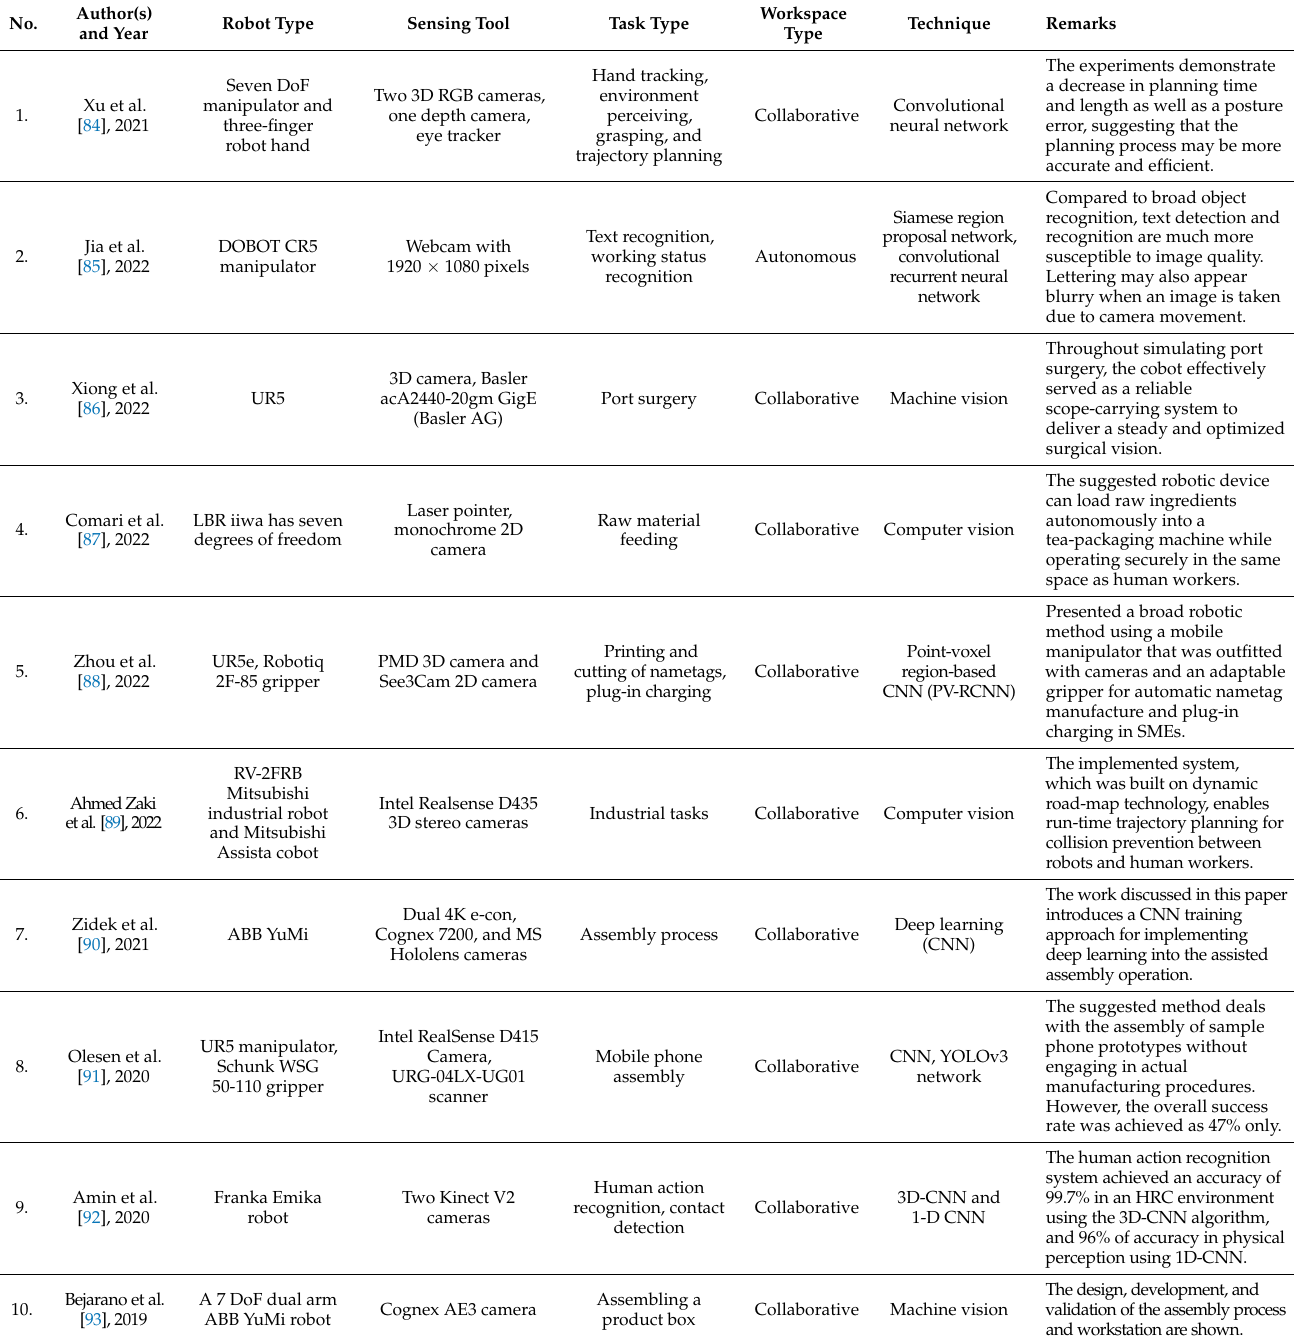
Table 6. Summary of the state-of-art research on vision systems employed in